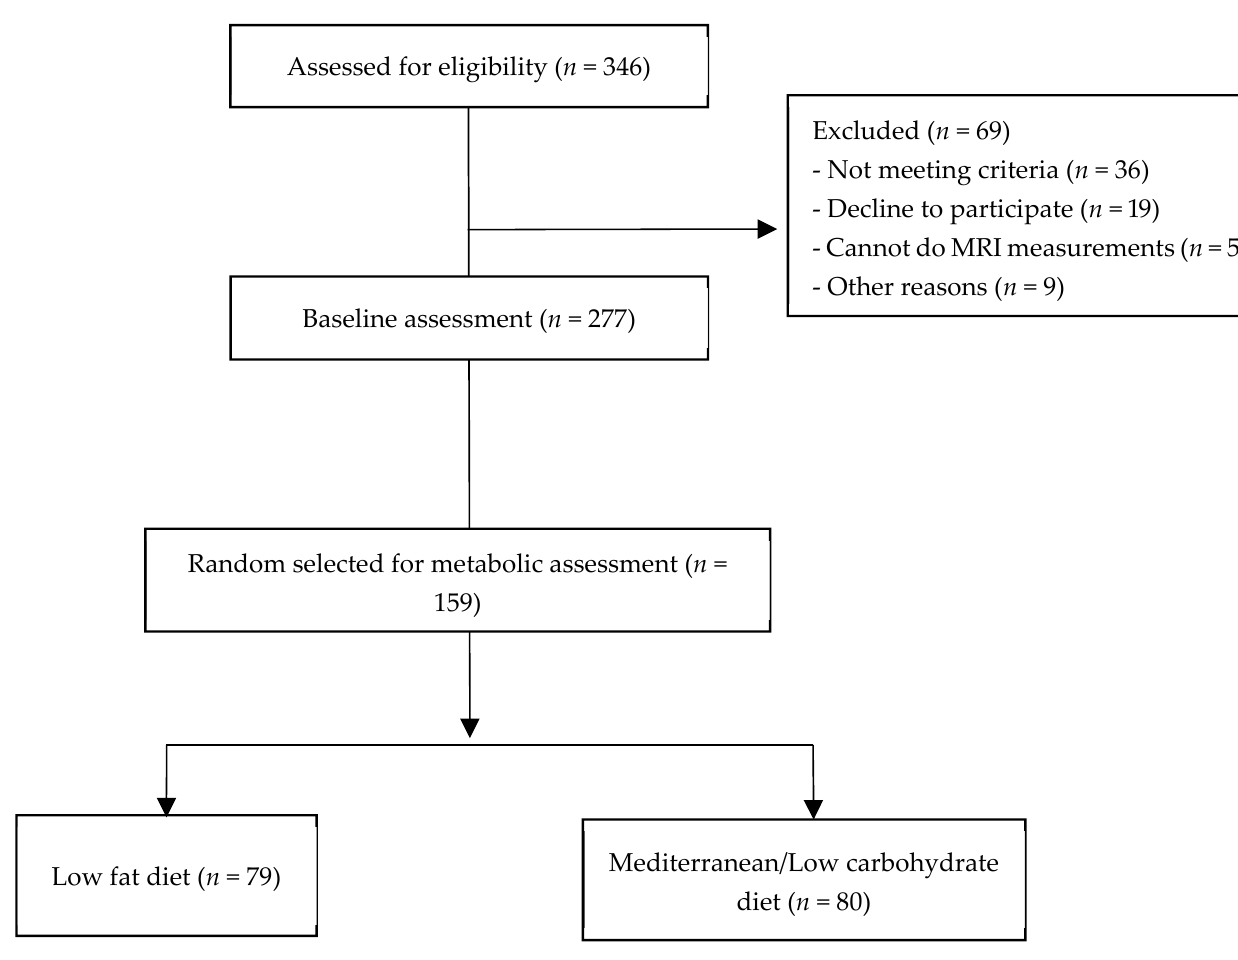
Figure 1. Flow chart of the CENTRAL metabolic sub-study.